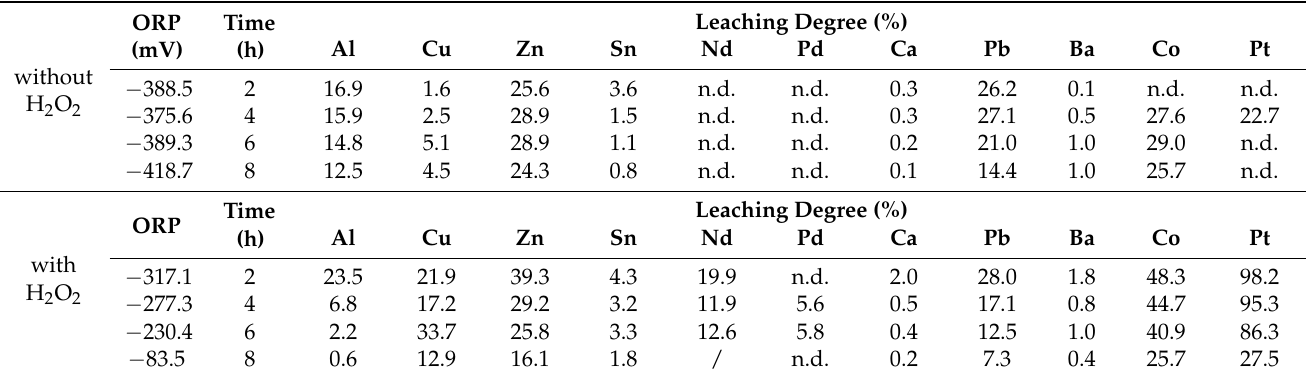
Table 3. Leaching degree for NADES leaching without and with hydrogen peroxide, respective ORP of leaching solution included.